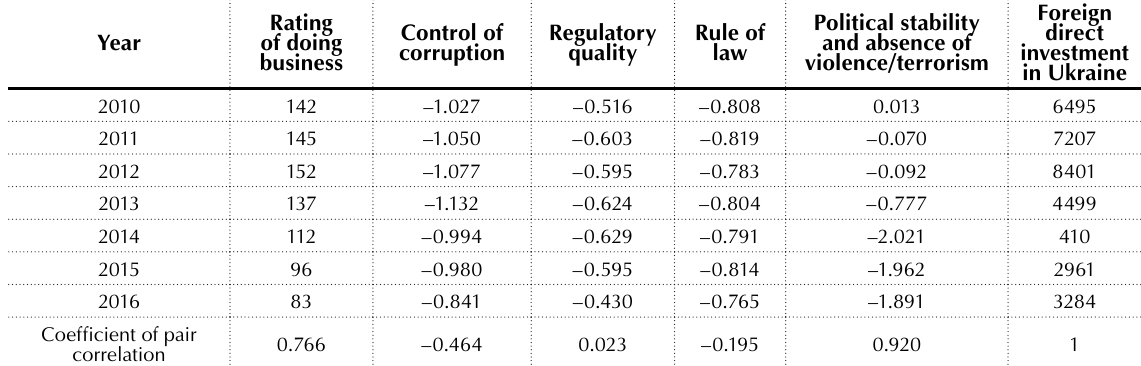
Table 4. Correlation between the volume of foreign direct investment flows into the economy and individual indicators characterizing investment attractiveness of Ukraine for 2010–2016